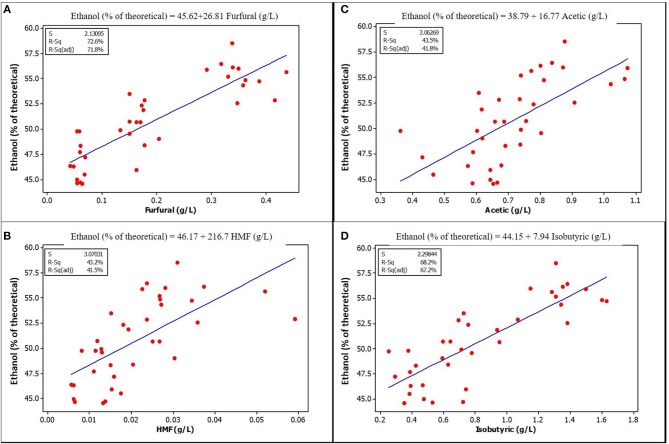
Relationships between ethanol yield and concentration of some potential inhibitors in the fermentation volume of unensiled stover that are significantly correlated (A) Furfural (B) HMF (C) Acetic acid (D) Isobutyric acid. See Supplementary Materials for correlation coefficients and p-values.